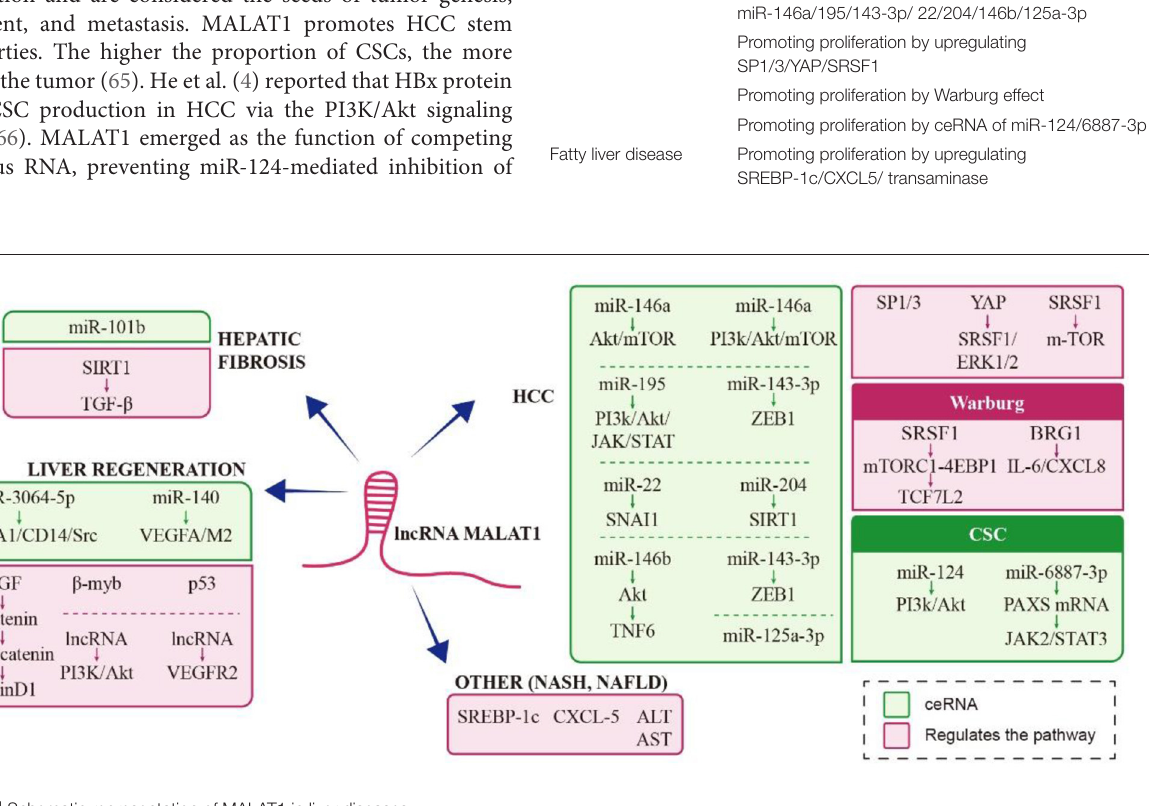
FIGURE 2 | Schematic representation of MALAT1 in liver